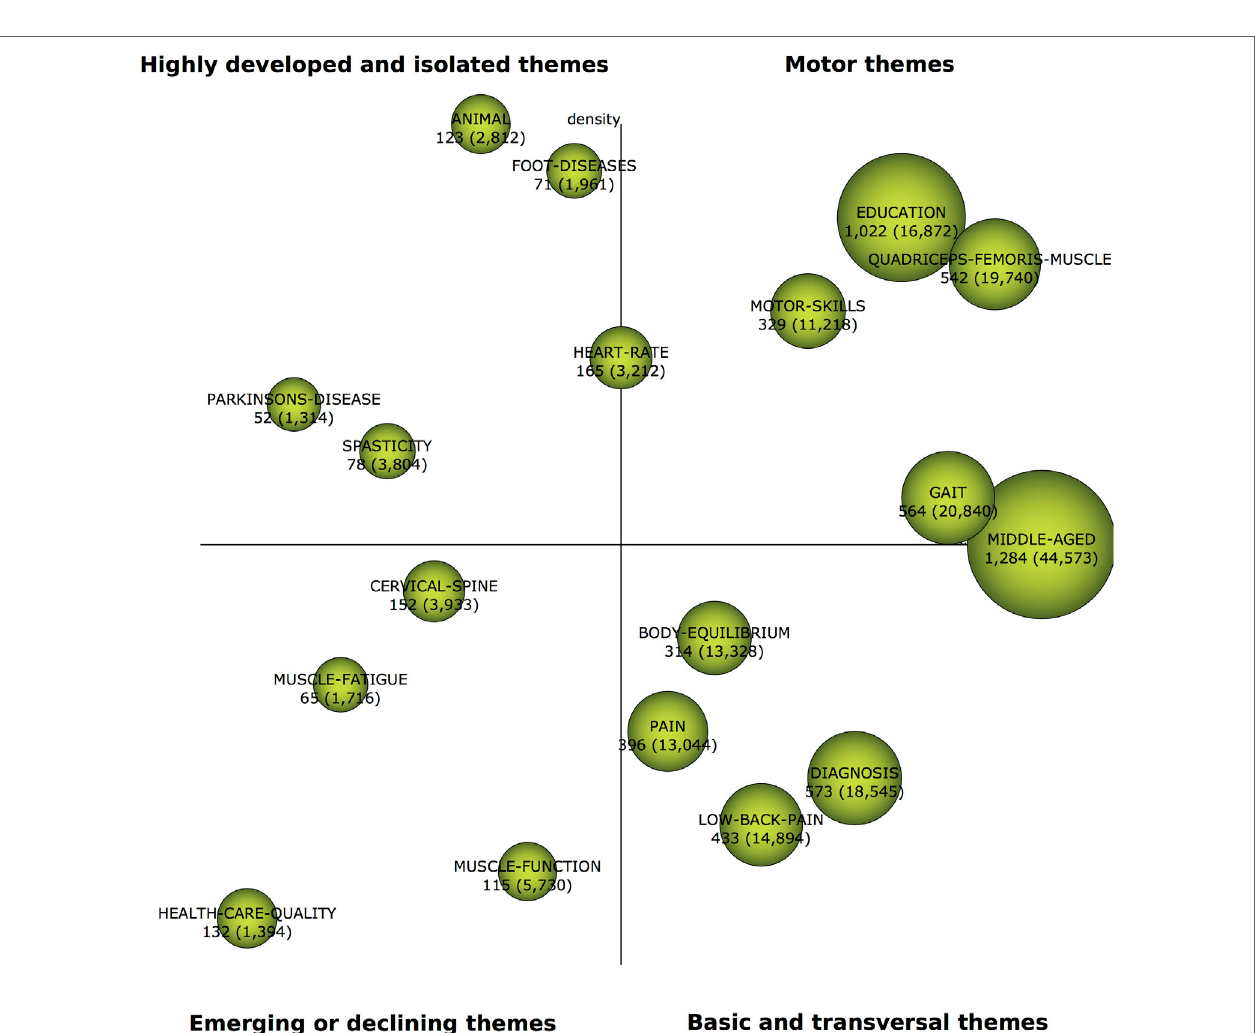
FigUre 4 | Strategic diagram for the subperiod 1985–2000.